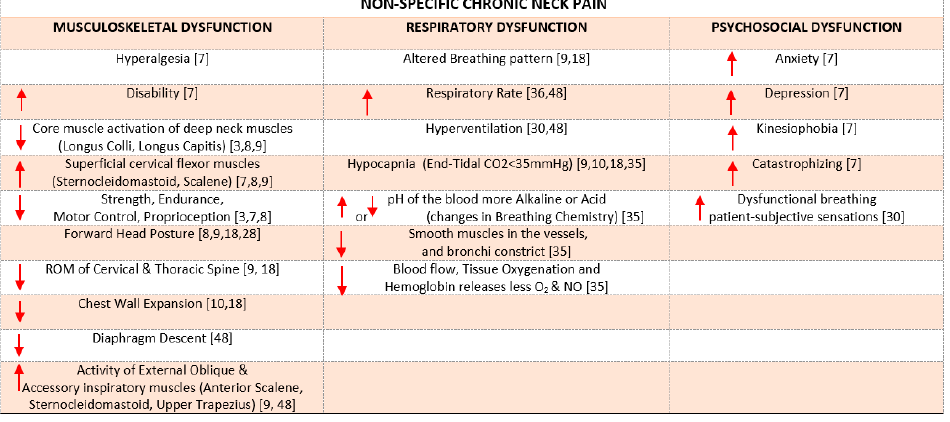
Figure 1. The three aspects of chronic neck pain dysfunction, with corresponding references. (red arrow mean increase or